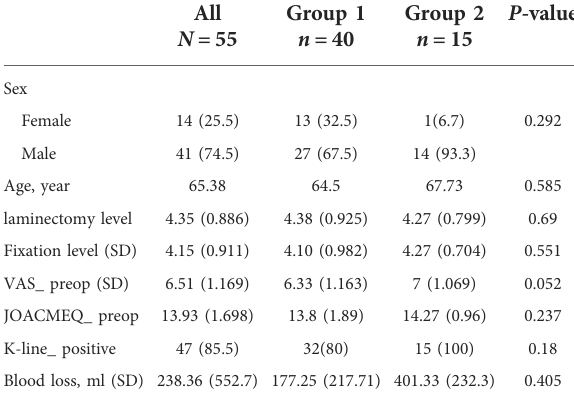
Table 2 Postoperative outcomes of 55 patients with CM due to long-segment massive OPLL undergoing cervical operation. Group 1 n =